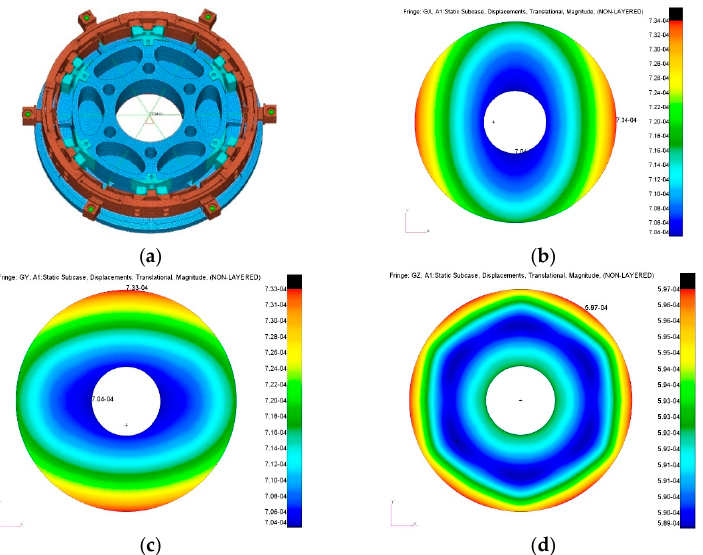
Figure 14. ( a ) FE model of the mirror assembly. ( b ) 1 g gravity along X direction. ( c ) 1 g gravity along Y direction. ( d ) 1 g gravity along Z direction. Mirror assembly FE model and surface displacement contour plot due to gravity.